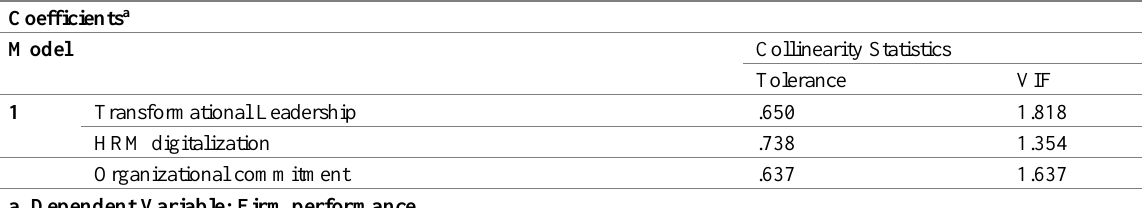
Table 3: Results of Multicollinearity Test